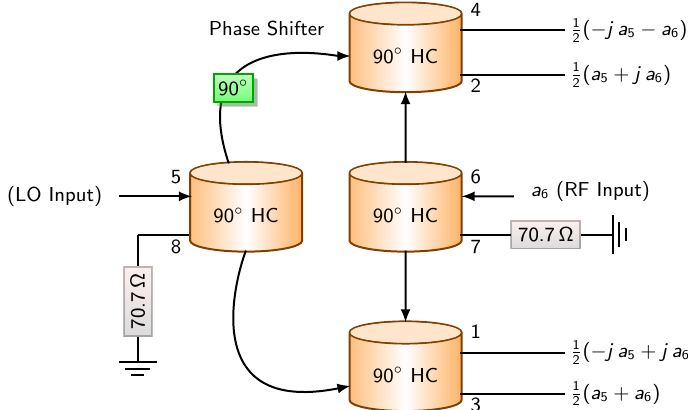
Figure 3. Block diagram of the six-port